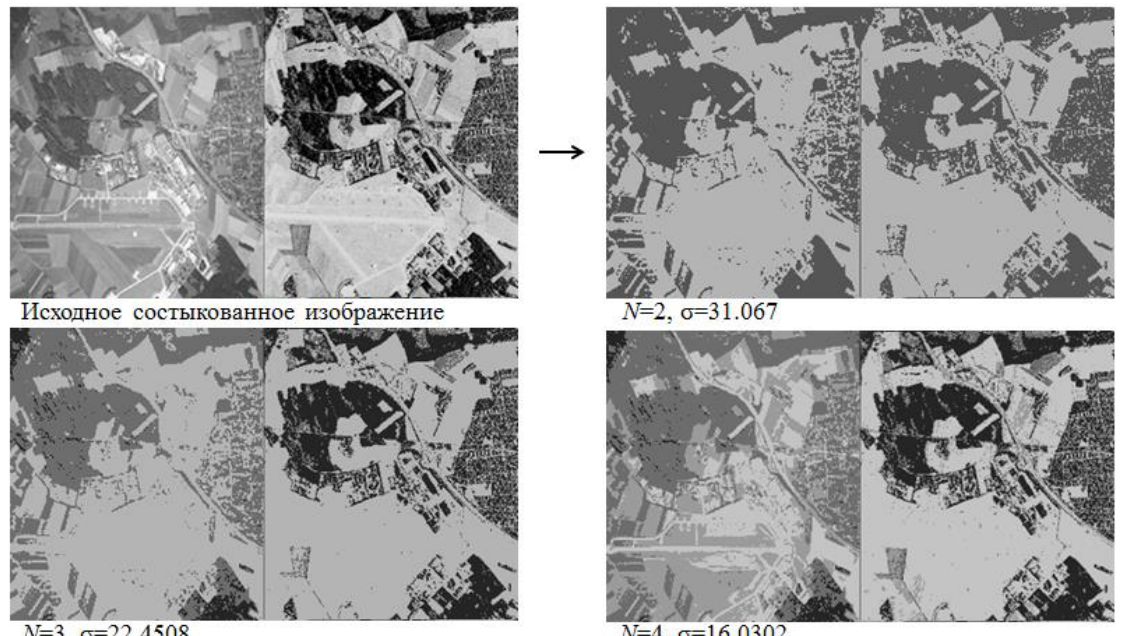
Figure 2 - part of a series of partitions of the docked optical and radar images into clusters of pixels by the method of